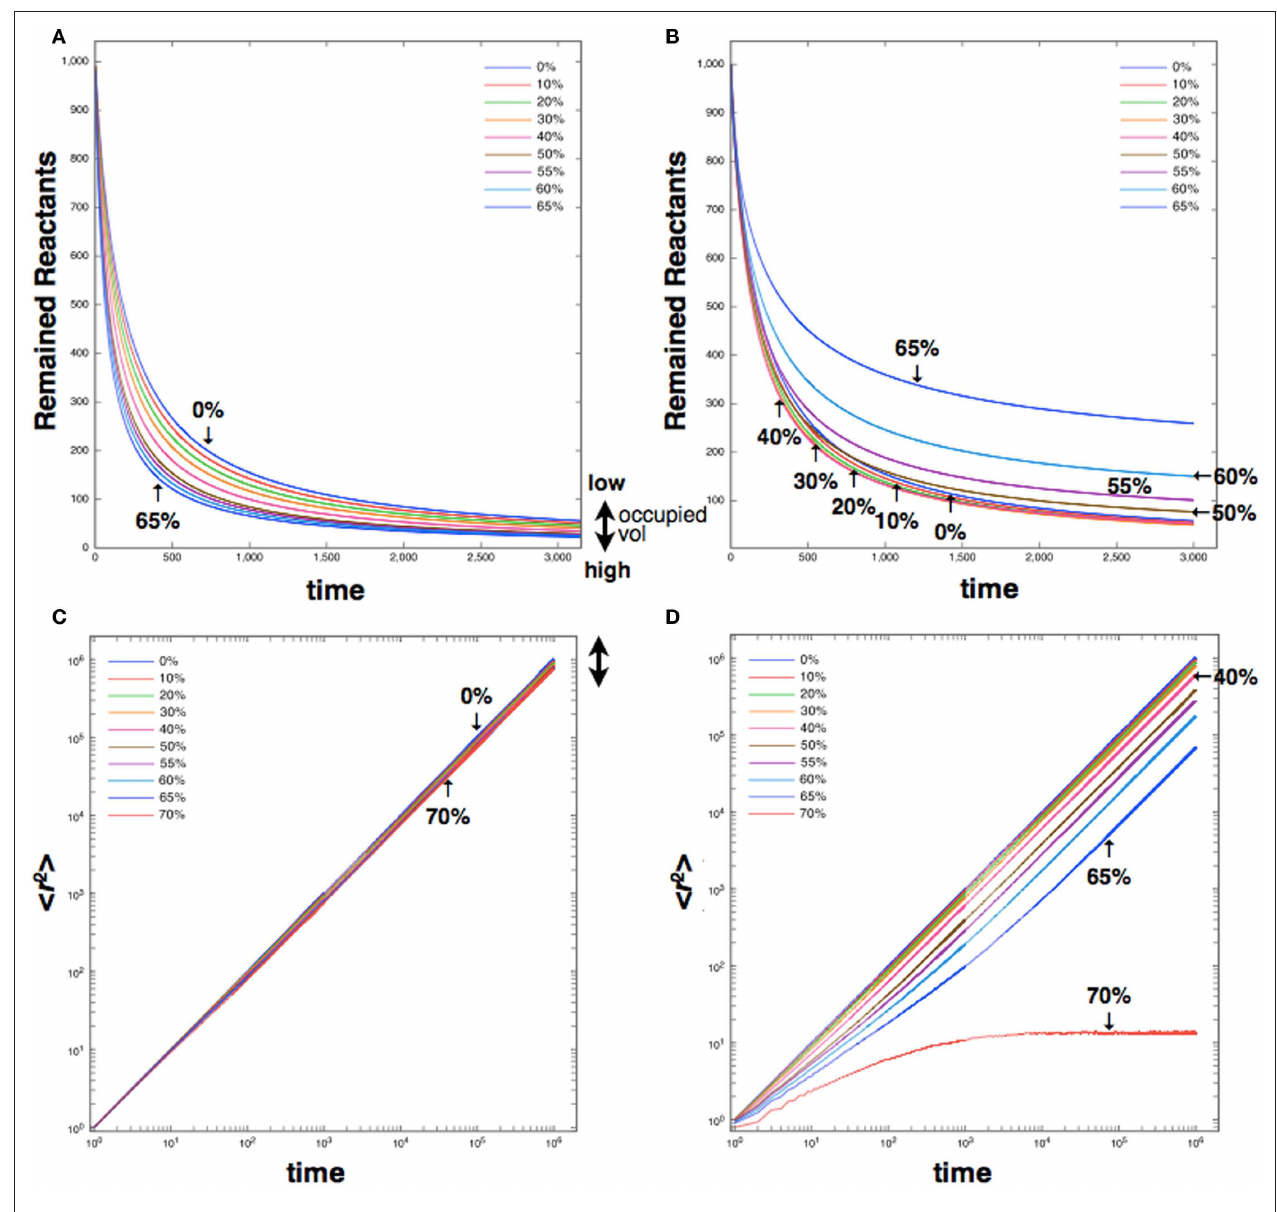
FiguRe A3 | Simulation results in 3D space with different shape of NRO. We simulated if the shape of NRO clusters in the simulation space affect the reaction processes. The test was performed with cubic NRO (A, C) or random